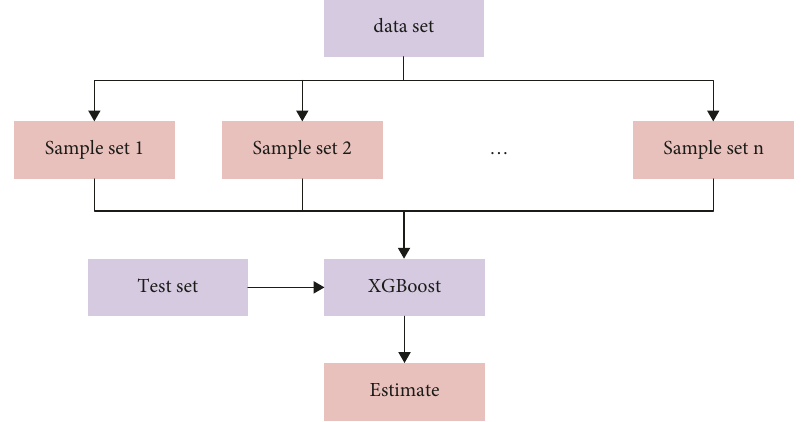
Figure 3: XGBoost flow